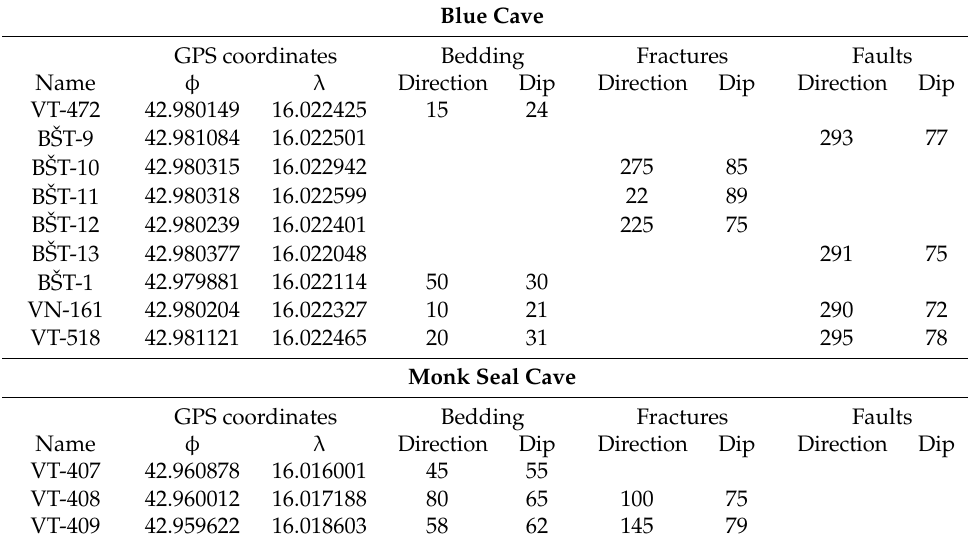
Table 2. Tectonic and depositional discontinuities measured at the surface of Biševo Island, in the close vicinity of the two caves. Blue Cave GPS coordinates Bedding Fractures